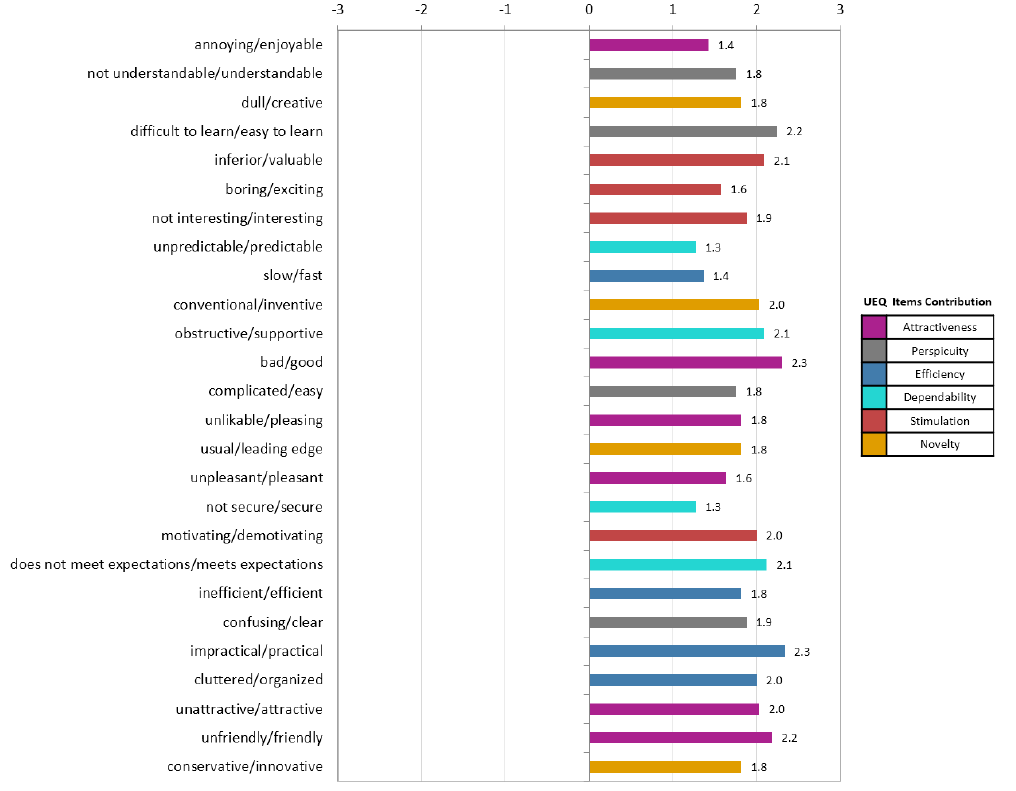
Figure 8. MIRA user experience questionnaire mean value per